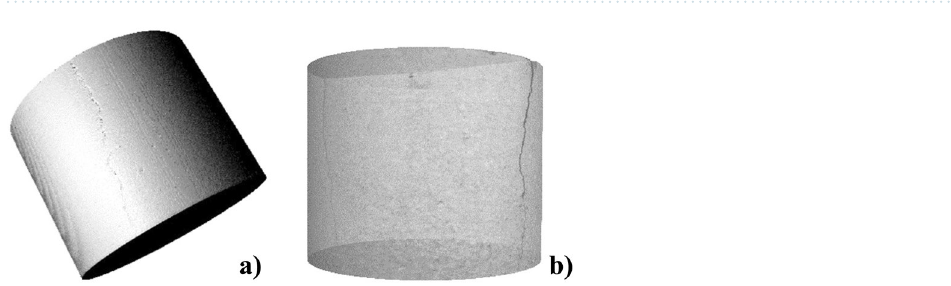
Figure 22. Disposition of the fracture in the sample. ( a ) 3D sample structure and ( b ) 3D sample structure with 50%